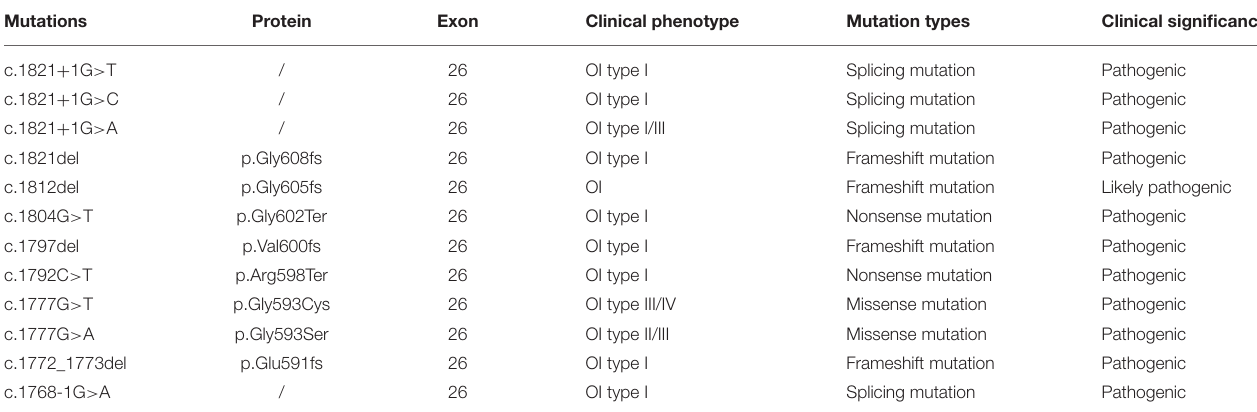
TABLE 1 | Mutations of the COL1A1 gene in exon 26 were reviewed in the ClinVar